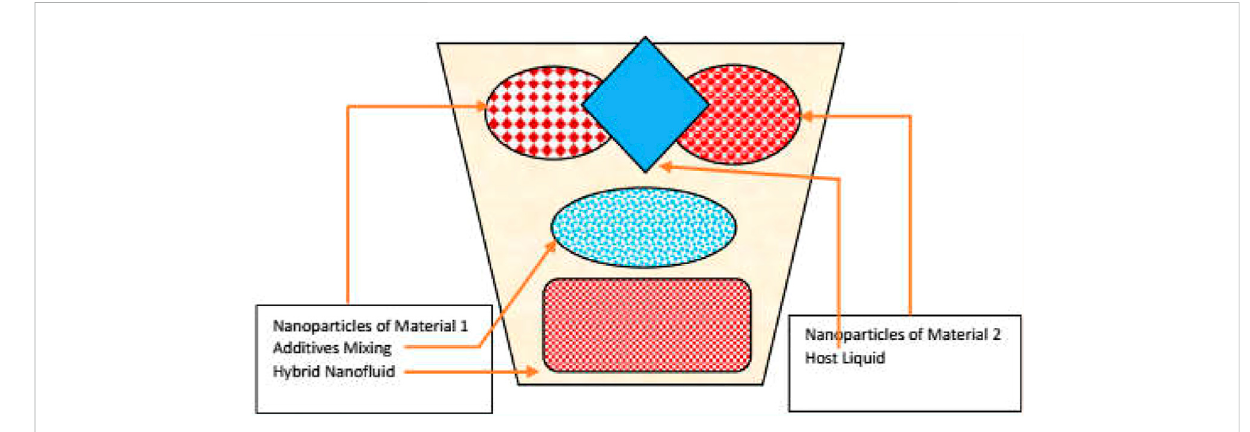
FIGURE 2 Second-generation heat transfer fl